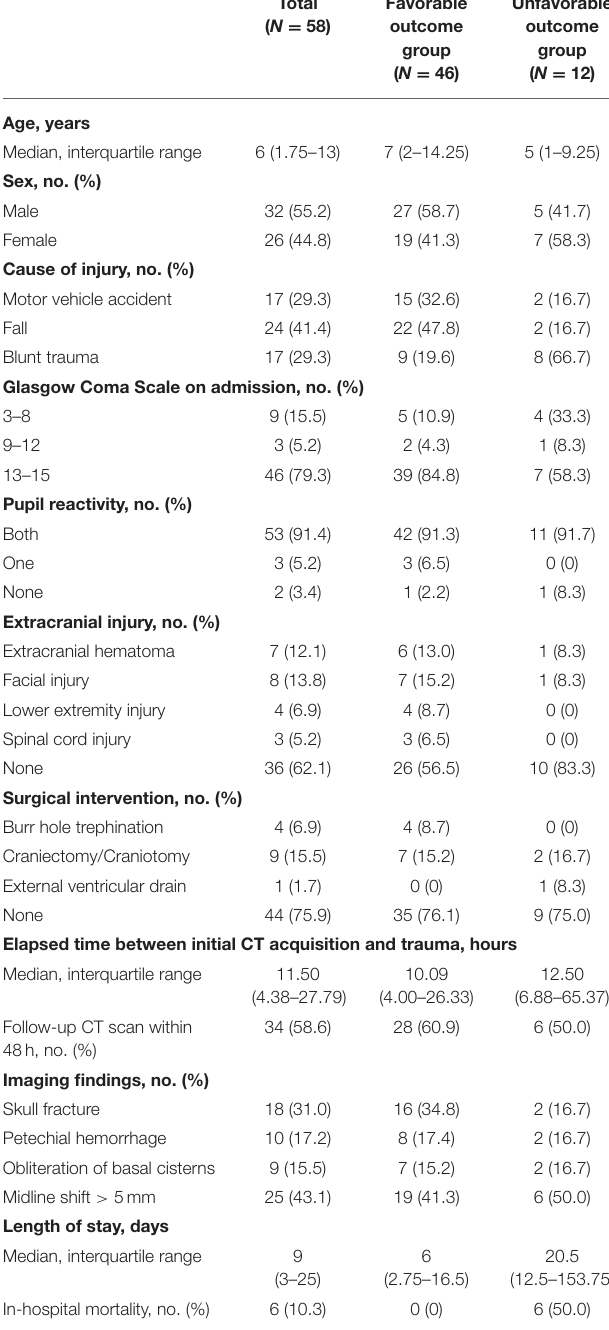
TABLE 1 | Baseline